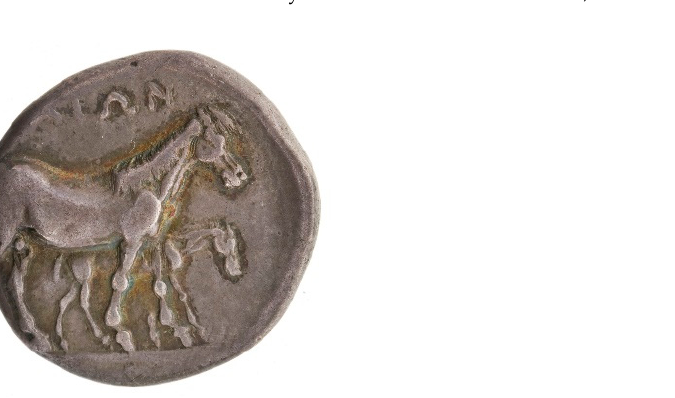
Figure 15. Silver drachm from Larissa. Bequest of E.T. Newell. American Nu-mismatics Society. Inv. no. 1944.100.16976.